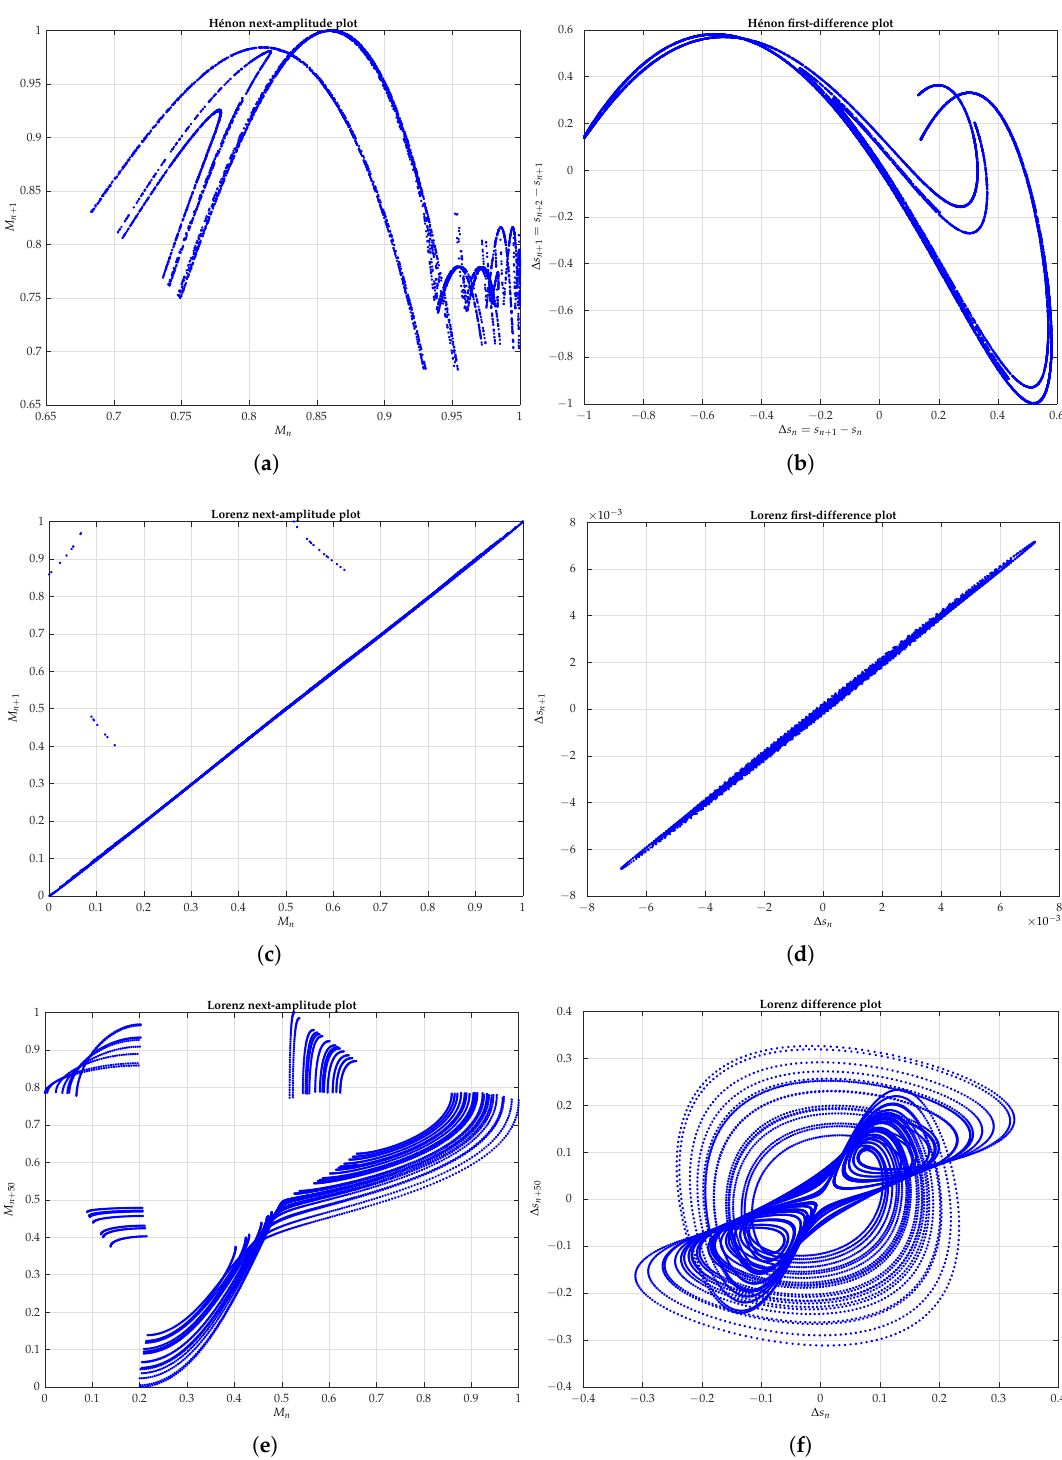
Figure 4. Next-amplitude and difference plots, from the dynamic variable x of the Hénon map and the Lorenz flow with a sampling time of 2 ms: ( a , b ) Hénon map with τ = 1; ( c , d ) Lorenz flow with τ = 1; ( e , f ) Lorenz flow with τ =